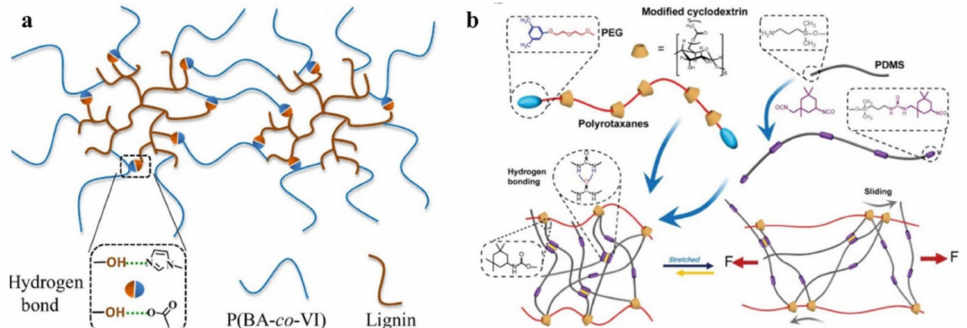
Figure 13. ( a ) Proposed H-bond interaction in the elastomers. Reproduced from [136] with permission from Elsevier. ( b ) Schematic representation of an elastomer cross-linked with polyrotaxanes and H-bond, illustrating the sliding behavior of cyclodextrins when the elastomer was stretched. Reproduced from [137] with permission from John Wiley and Sons.